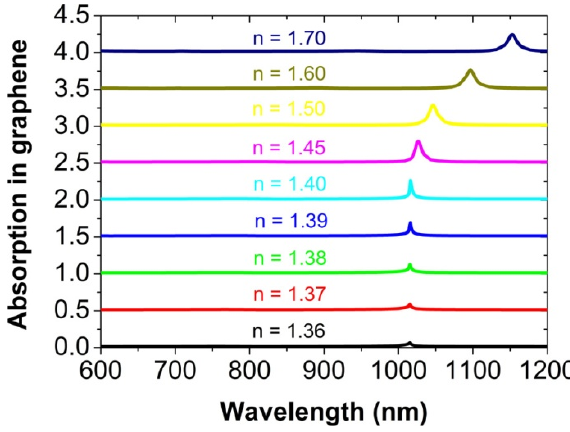
Figure 6. The calculated absorption spectra of the graphene monolayer for the different refractive index n of the cover layer at normal incidence. For clarity, the above absorption spectrum is vertically offset by 0.5 from the one below.